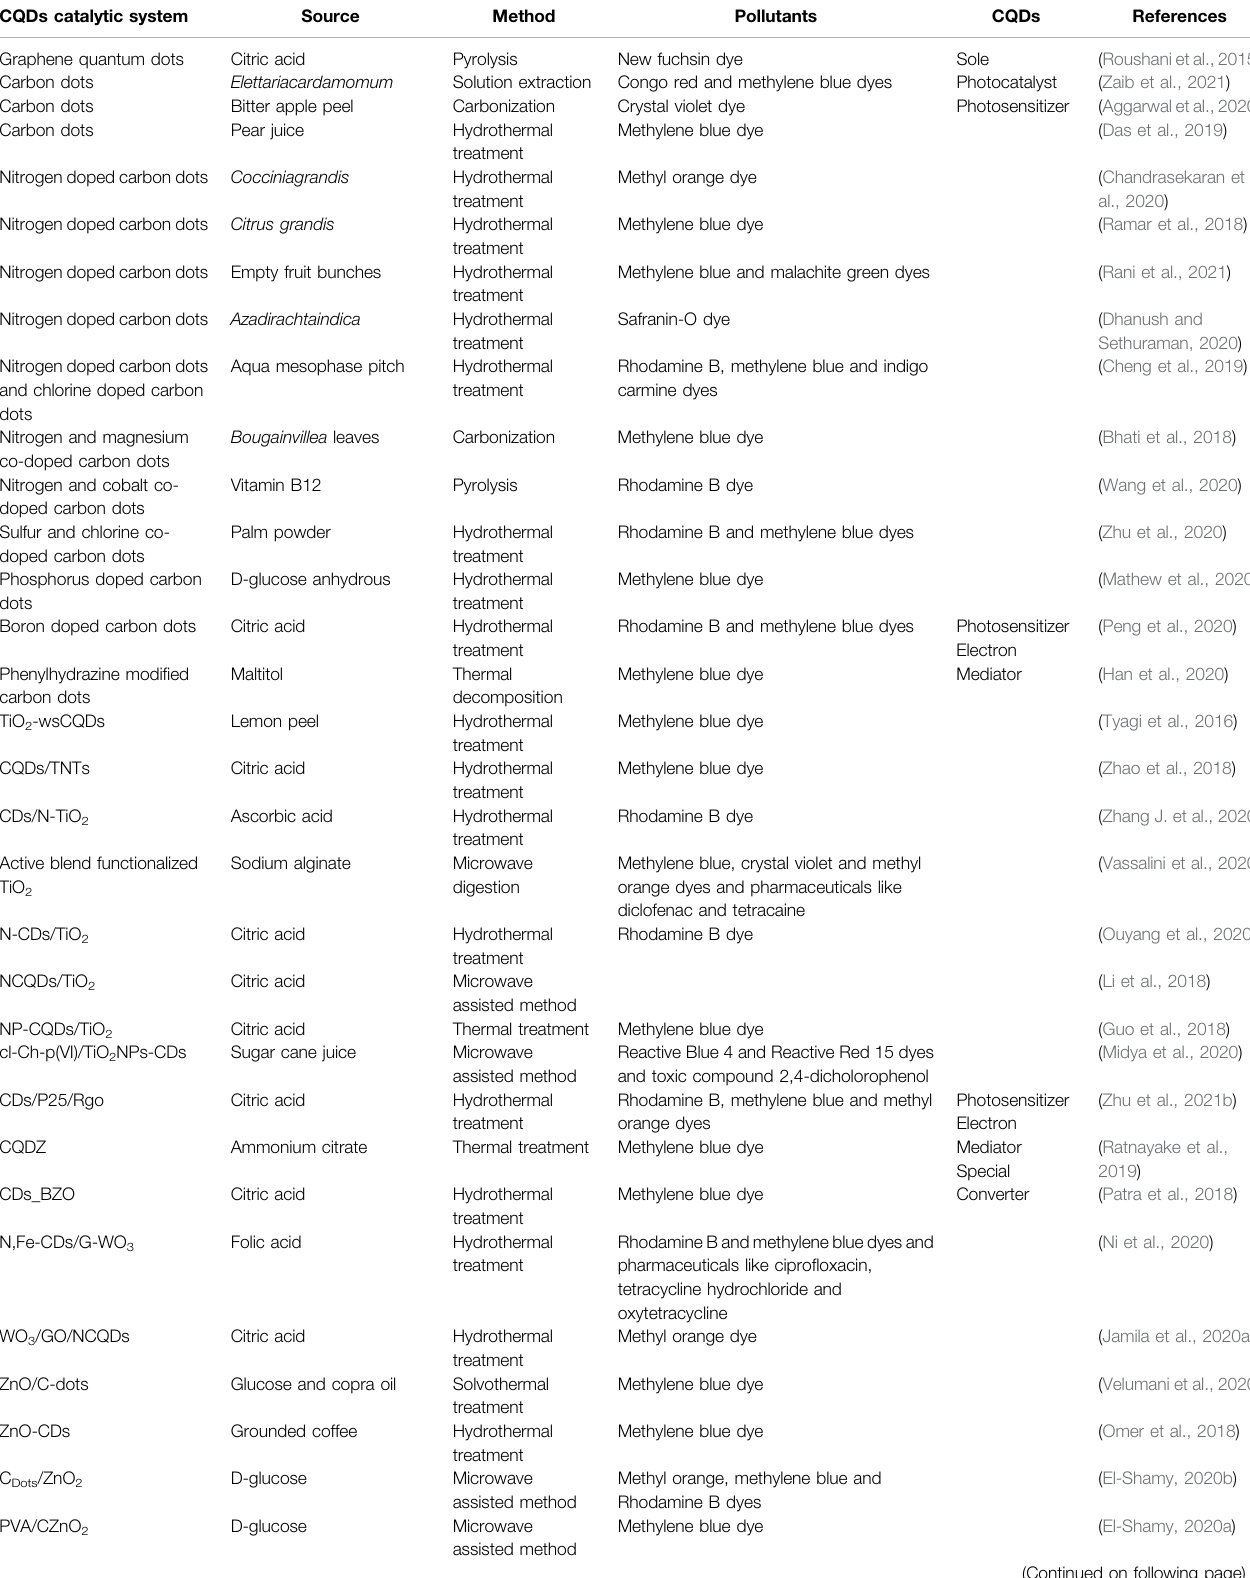
TABLE 1 | CQDs-based materials ’ synthesis and application in photocatalytic pollution control